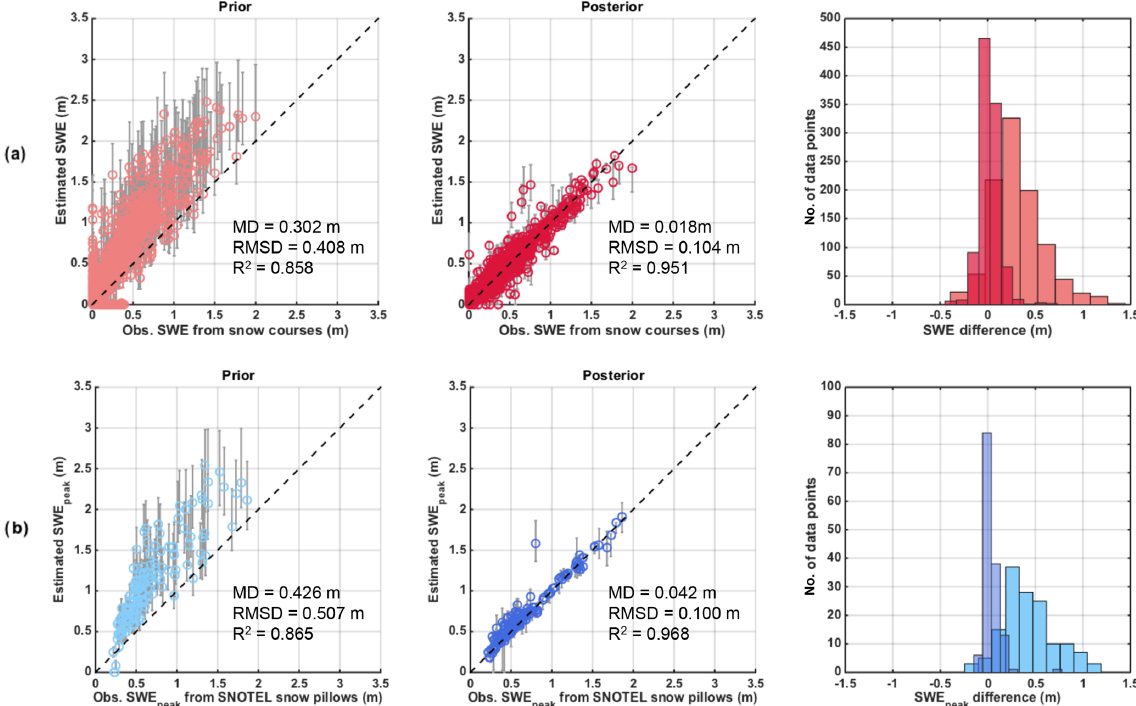
Figure 4. Left panels show scatter plots of prior estimated snow water equivalent (SWE) vs. in situ, middle panels show posterior estimated SWE vs. in situ, and right panels show histograms of the difference for (a) all snow courses and (b) snow pillows. The markers represent en- semble medians while the intervals represent the interquartile range (IQR). The mean difference (MD), root mean square difference (RMSD), and correlation coefficient ( R 2 ) are